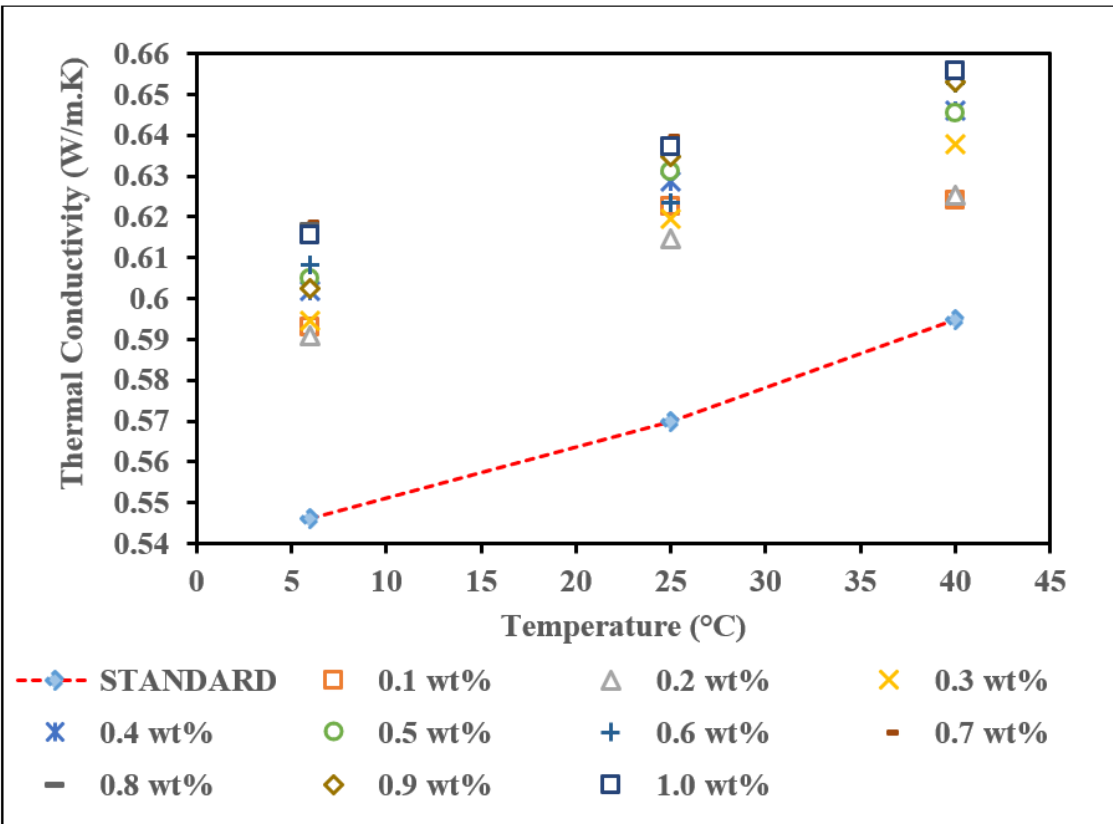
Figure 10. Thermal conductivity of surface oxidized MWCNTs based nanofluid without PVP with various concentrations at different temperatures. Table 7. Thermal conductivity enhancement of surface oxidized MWCNTs nanofluid without PVP. Weight Concentration of Surface